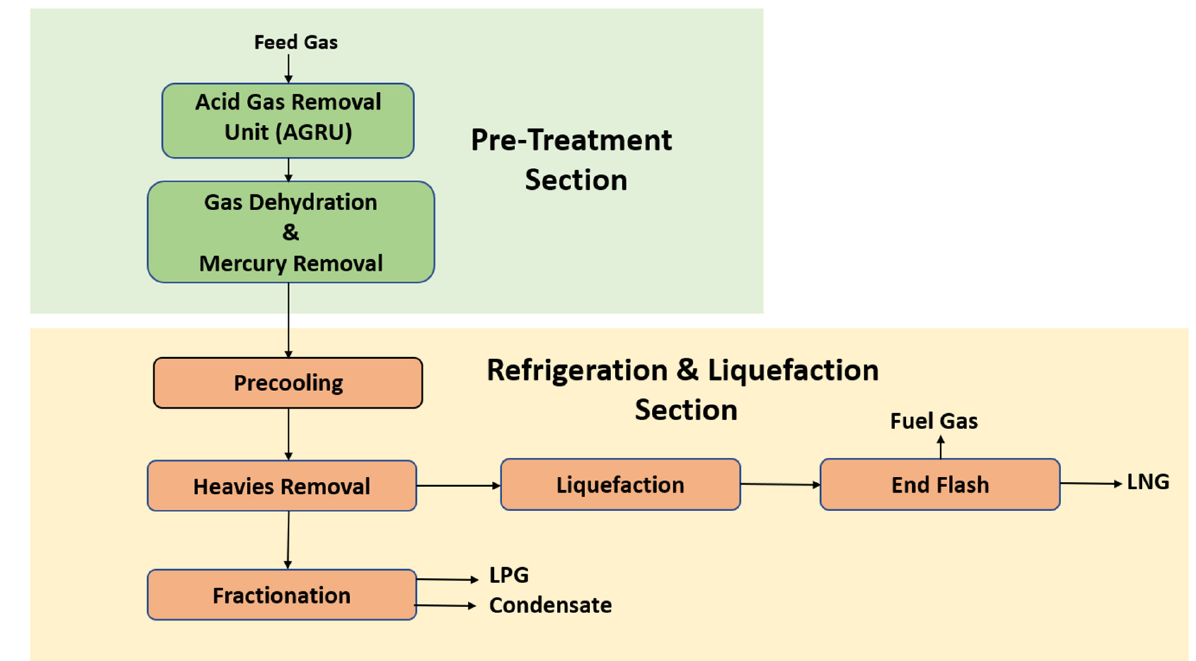
Figure 1. Block Diagram of a Typical LNG Plant.